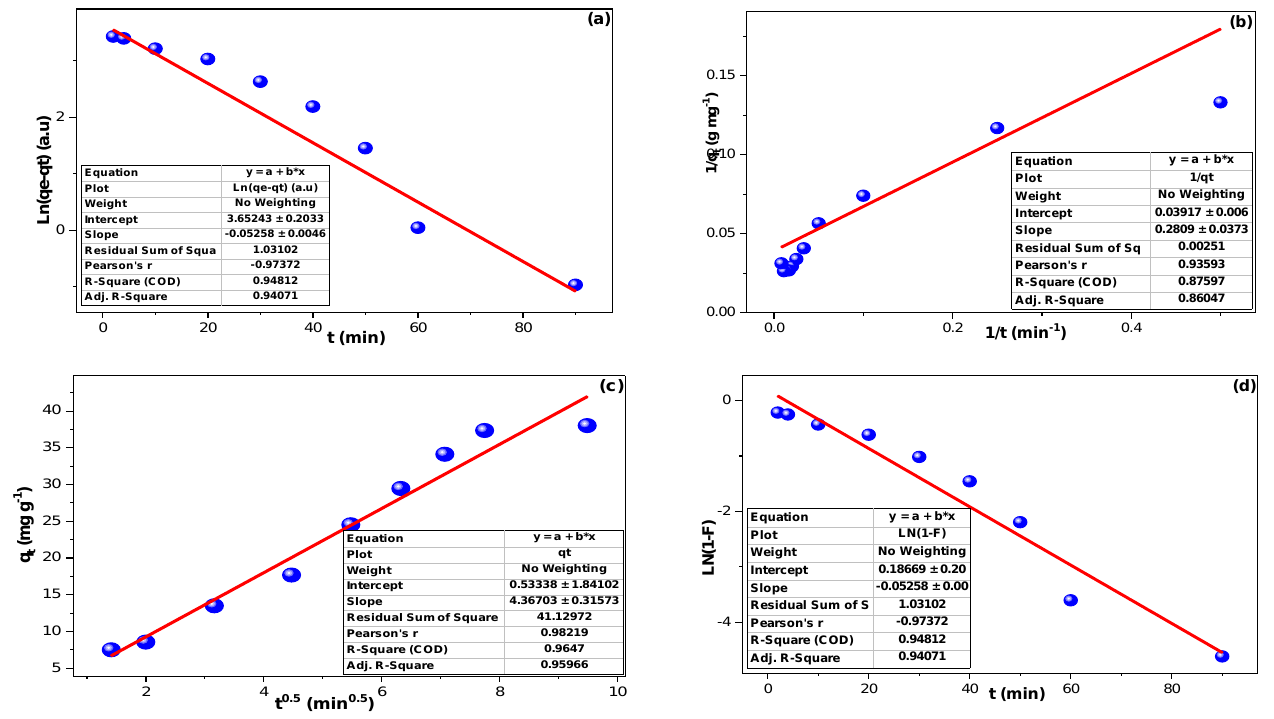
Figure 6. ( a ) PSFO, ( b ) PSSO, ( c ) IPDM, and ( d ) LFDM investigations for the adsorption of IC on BiOI nanoparticles.